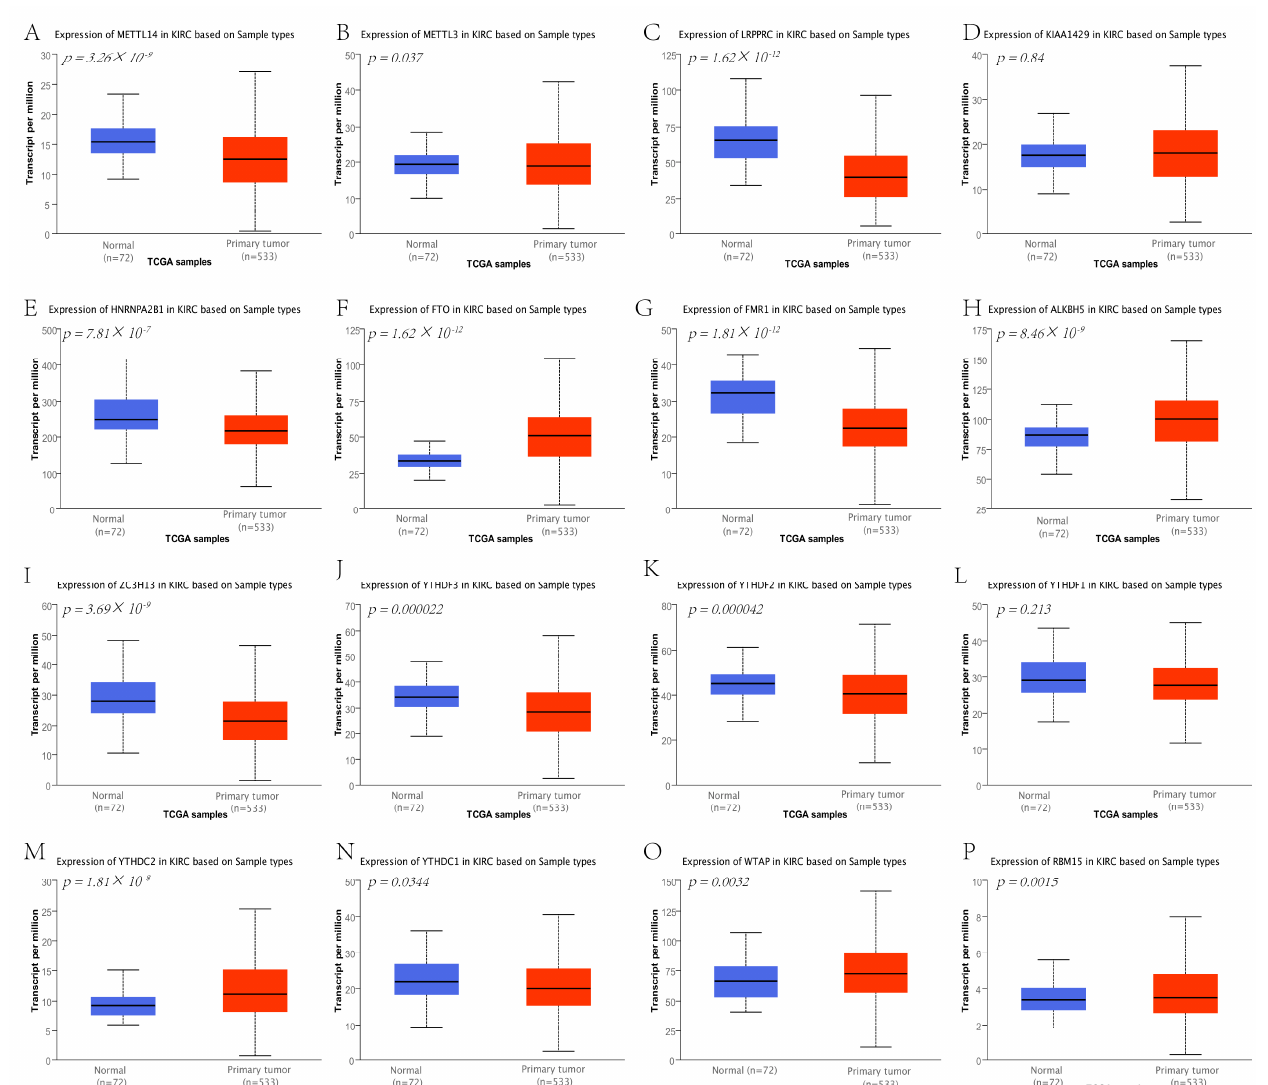
Figure 12. The expression of m6A-related genes using UALCAN. The box plots show the expression of m6A-related genes in RCC and normal tissues. FTO ( F ), ALKBH5 ( H ), YTHDC2 ( M ), WTAP ( O ), and RBM15 ( P ) were highly expressed in the tumor group. METTL14 ( A ), METTL3 ( B ), LRPPRC ( C ), HNRNPA2B1 ( E ), FMR1 ( F ), FMR1 ( G ), ZC3H13 ( I ), YTHDF3 ( J ), YTHDF2 ( K ), YTHDC1 ( N ) have higher expression in normal tissues. The expression of KIAA1429 ( D ) and YTHDF1 ( L ) was not significantly different.